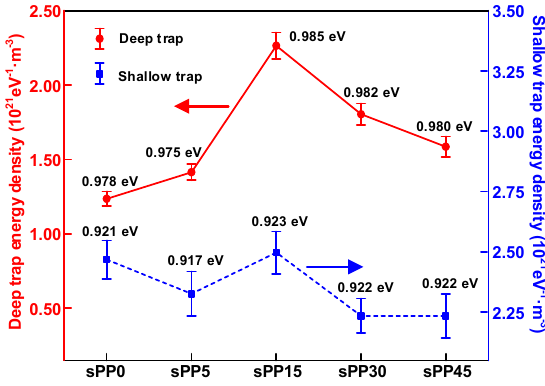
Figure 11. Trap level characteristics of iPP/sPP blends.